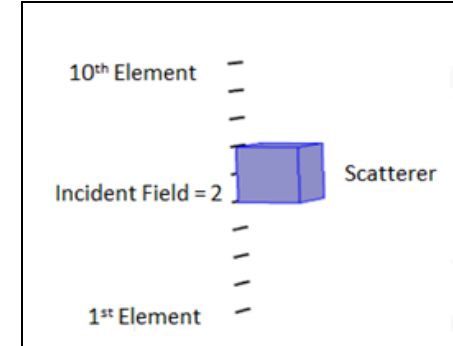
Figure 7: Geometric setup for case 2(a)